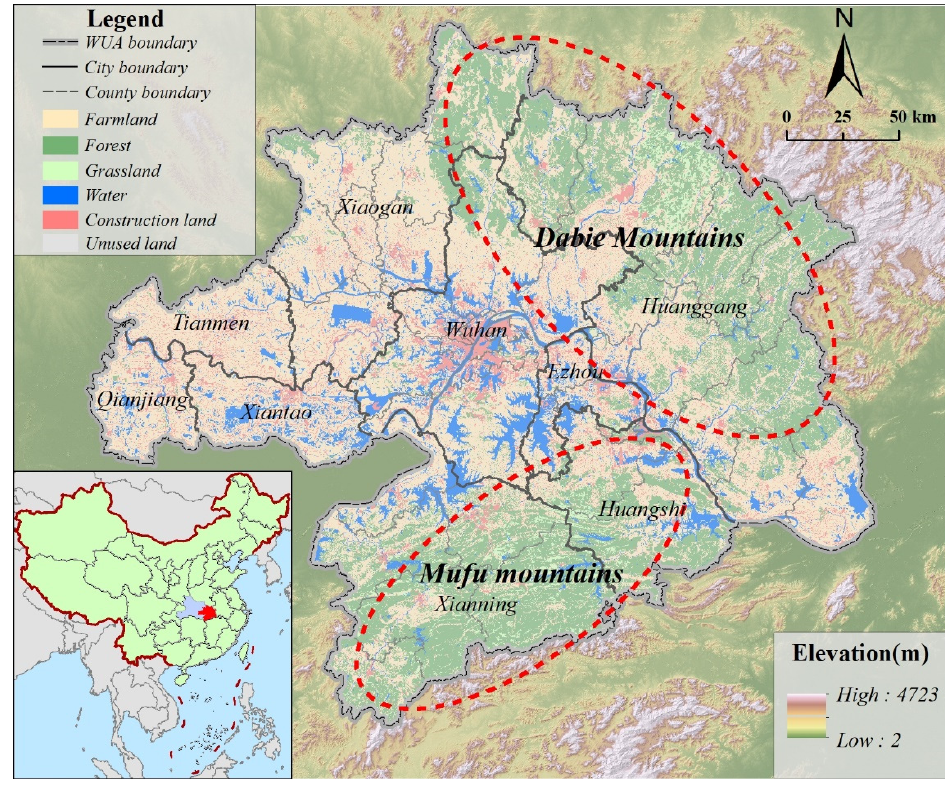
Figure 1. Administrative divisions, spatial distribution data of land use types for Wuhan Metropolis (WUA) in 2020.